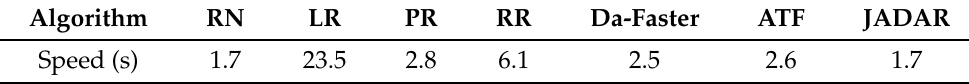
Table 4. Comparison of different network recognition speeds